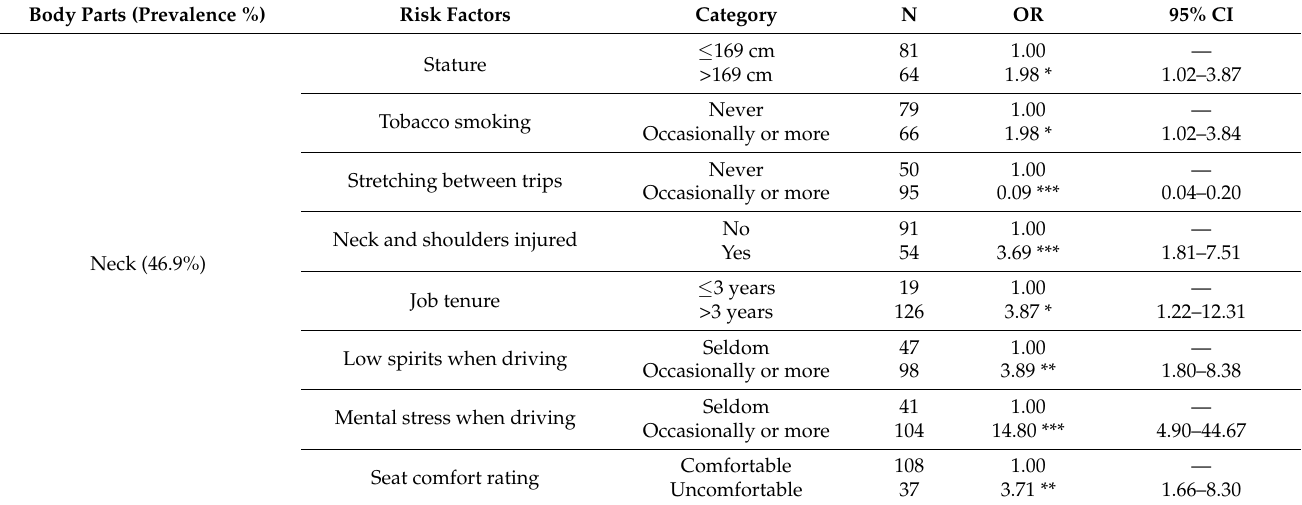
Table 4. Risk factors significantly associated with musculoskeletal